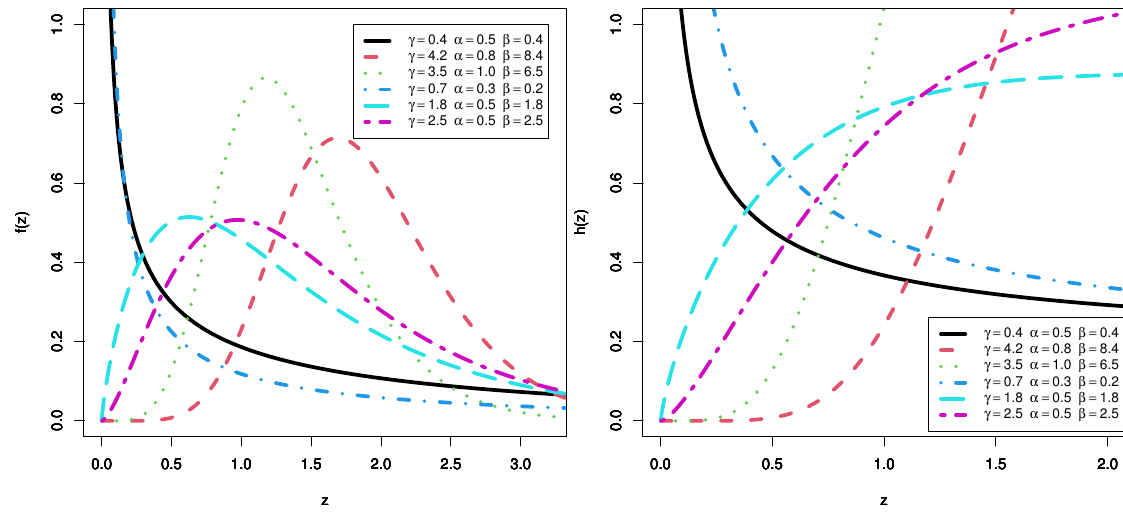
Figure 2. Plots of pdf and hrf for the KMKE model.